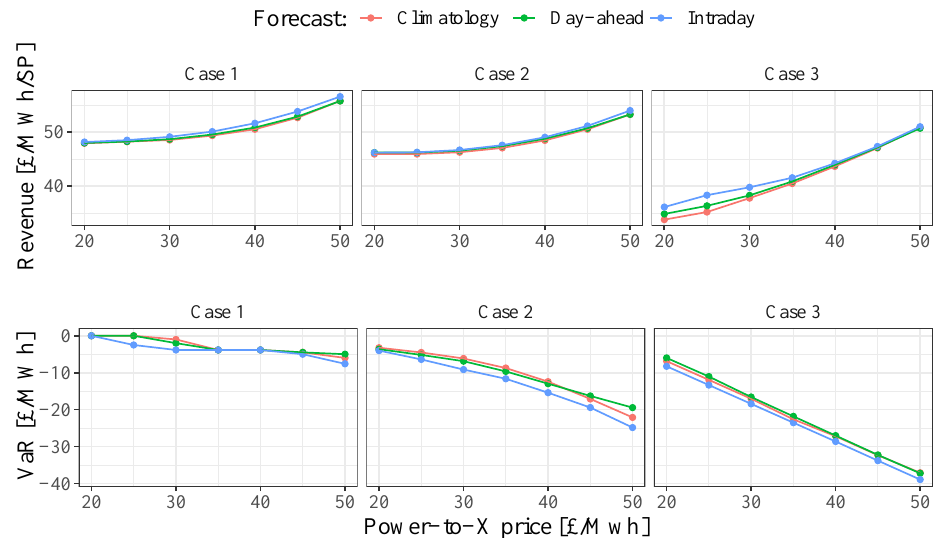
Figure 3. Results for Cases 1–3 with Climatological, Day-ahead, and Intraday imbalance price forecasts. Forecast skill translates into increased revenue and reduced risk, particularly by the risk-constrained strategy, which successfully controls risk at the 1% VaR = 10 − π X